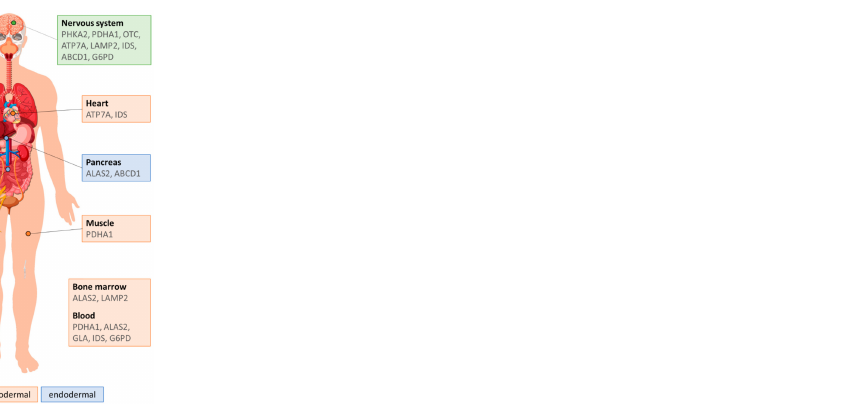
Figure 2. Tissues in which proteins are affected in the disorders described in this review are most abundantly produced and their embryonic origin. Tissue protein expression is based on data obtained from GeneCards ® : The Human Gene Database; https://www.genecards.org/ (accessed on 27 January 2021) available as data integrated from literature manual curation, proteomics, and transcriptomics screens, and automatic text mining. Origin from germ layers is indicated for each tissue. Figure created using the human body figure designed by brgfx/Freepik (www.freepik.com; accessed on 27 January